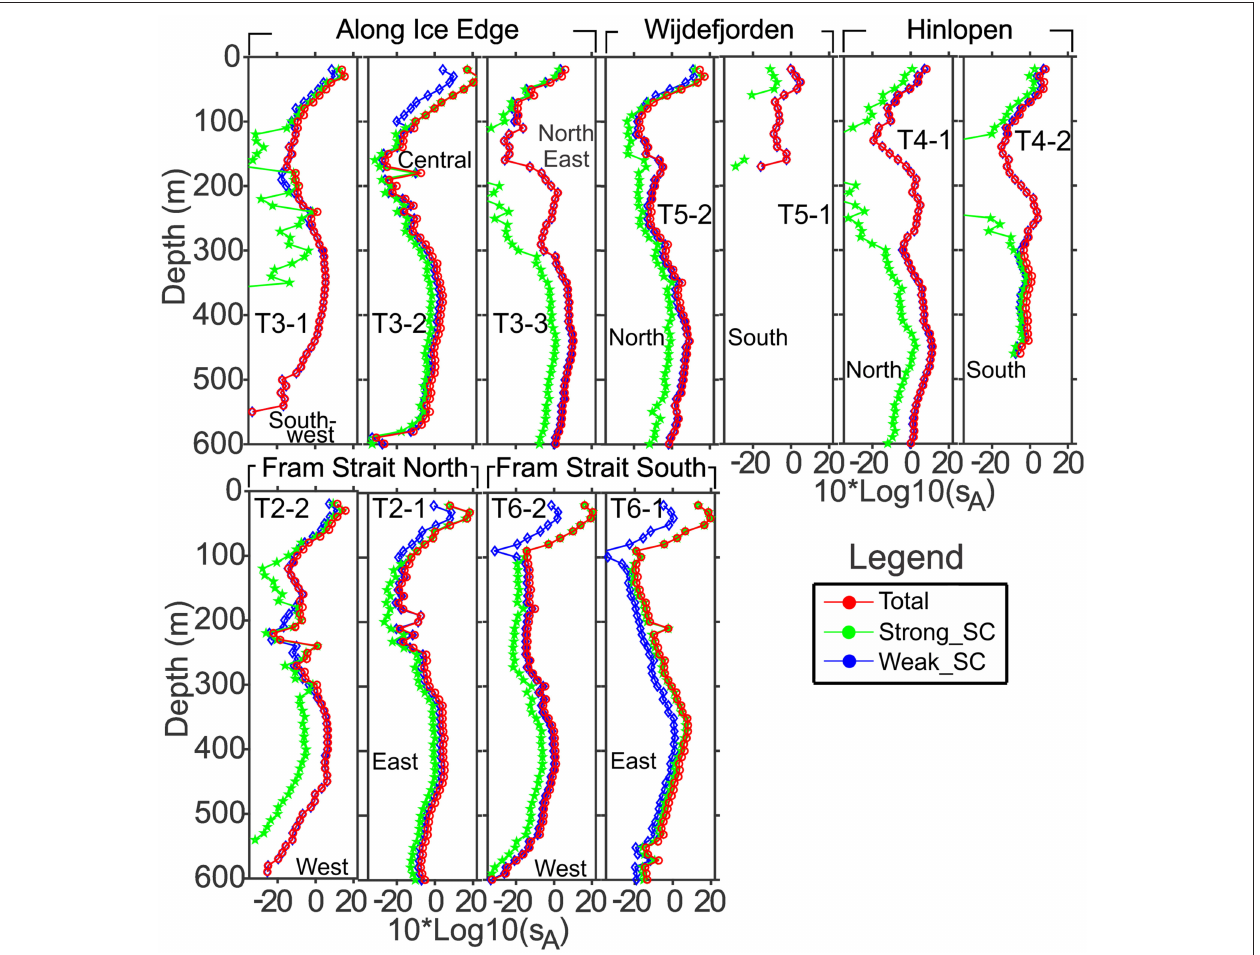
FIGURE 6 | Subsection averaged vertical profiles of acoustic backscattering s A , Nautical area scattering coefficient in units of (m 2 nmi − 2 ) for the categories Weak_SC, Strong_SC and Total s A , presented as Nautical area scattering strength, S A = 10*Log10 (s A ), dB re 1(m 2 nmi − 2 ). T2, Fram Strait North; T3, Along Ice Edge; T4, Hinlopen; T5, Wijdefjorden; T6, Fram Strait